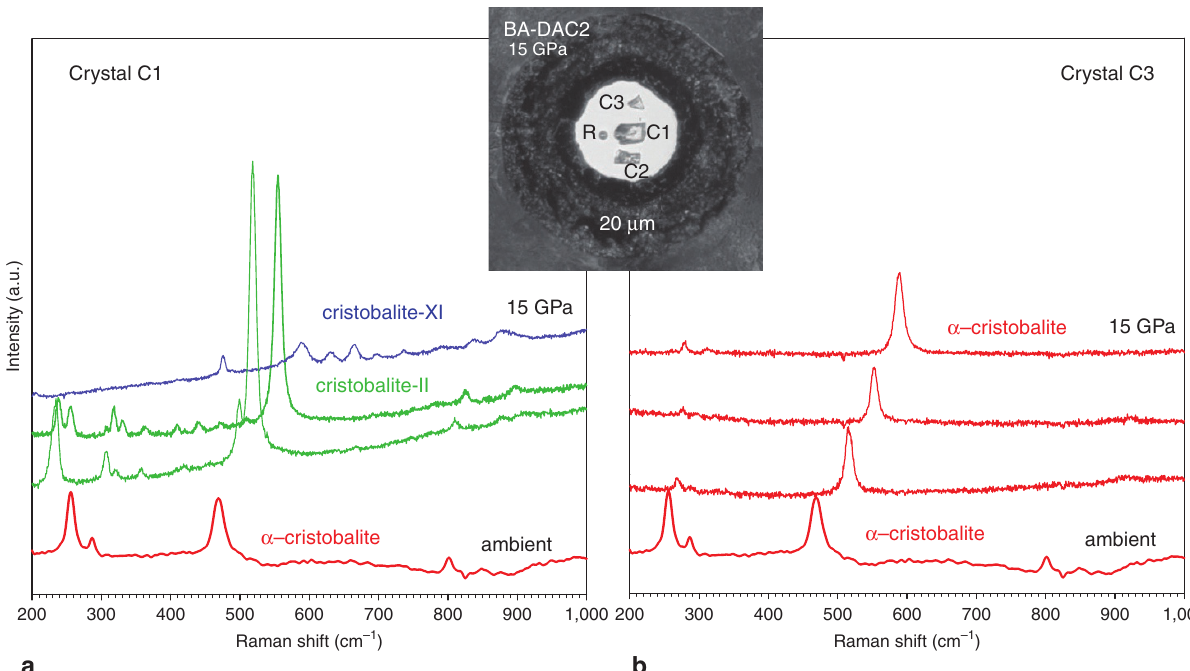
Figure 1 | In situ Raman spectra of cristobalite at high pressures. Spectra collected on two different single crystals of a -cristobalite at 1.1, 4.6, 8.6 and 15.0GPa and at room temperature. Inset shows the DAC pressure chamber seen at 15.0GPa: R stands for ruby; C1, C2 and C3 for different cristobalite crystals. In quasi-hydrostatic conditions ( a ) the crystal C1 starting as a -cristobalite (red) transforms via intermediate cristobalite-II (green) to cristobalite X-I (blue). However, in the case of high hydrostaticity ( b ), the smallest crystal C3 retains its initial structure of a -cristobalite (red). All spectra are unsmoothed, the background has been subtracted. Ar þ laser was used (514nm excitation wavelength) with B 0.8W incident beam